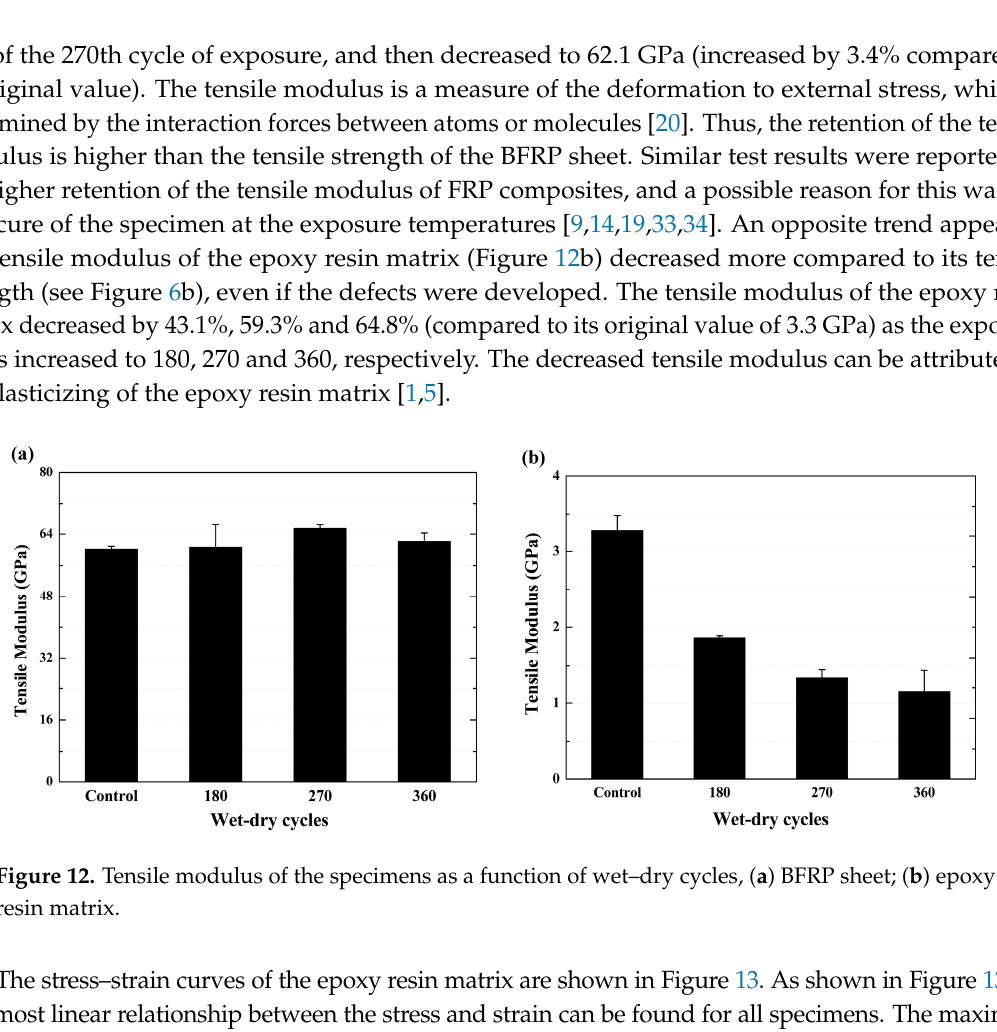
Figure 11. The morphologies of the BFRP sheets exposed for 180 cycles, ( a ) interface; ( b ) fiber.